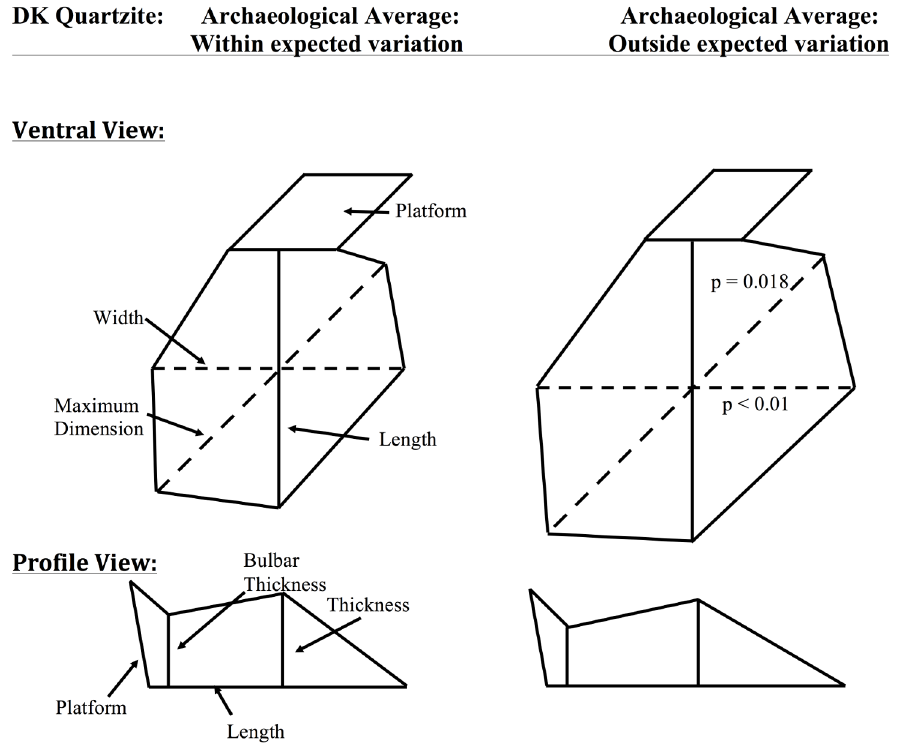
Fig 7. Schematic images of average quartzite flakes from DK, Olduvai Gorge falling within and outside of expected variation. These images represent idealized, schematic drawings of average measurements for Olduvai Gorge archaeological flakes from the site of DK that are made from quartzite. The first column shows the ventral and profile views of the average DK flakes that fall within experimentally expected variation. The second column shows the ventral and profile views of the average DK flakes that fall outside of experimentally expected variation. For consistency and ease of comparison, the maximum dimension was placed at a 45-degree angle from the length measurement. All measurements are still size standardized, but are translated into “ inch ” units, such that if the average size-standardized length measurement is 1.0, this becomes 1.0 inch in this image. Similarly, average platform area is depicted as a square, such that platform width and thickness are equal and both are the square root of average platform area. Significant differences between outside-of-range and within-range assemblages are dotted lines, p- values are